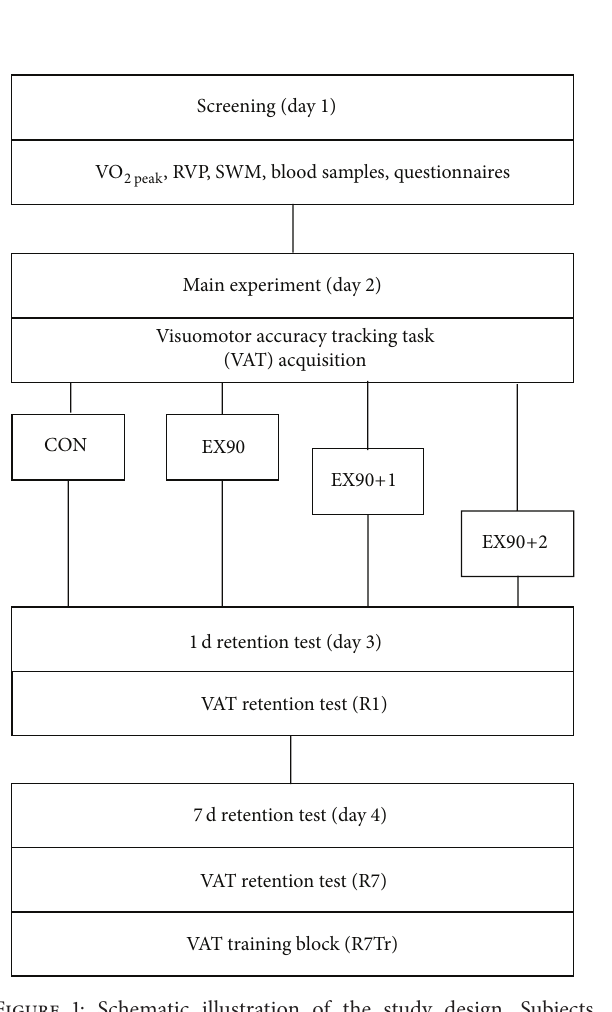
Figure 1: Schematic illustration of the study design. Subjects reported to the laboratory 4 times. Screening (day 1) involved baseline testing. The main experiment included acquisition of the VAT and the intervention. Retention tests were conducted at exactly 1d (R1) and 7d (R7) after main experiment. VO 2 peak = maximal oxygen consumption; RVP = rapid visual processing (sustained attention). SWM = spatial working